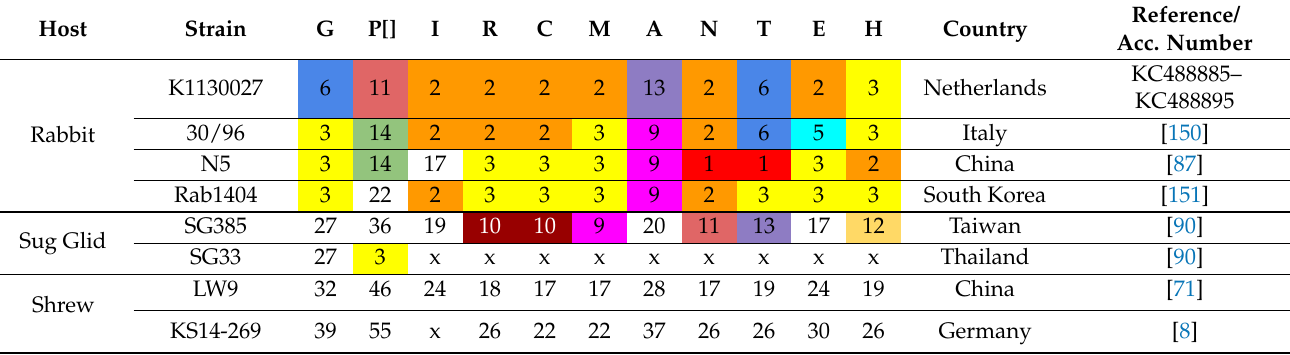
Table A13. Other animals